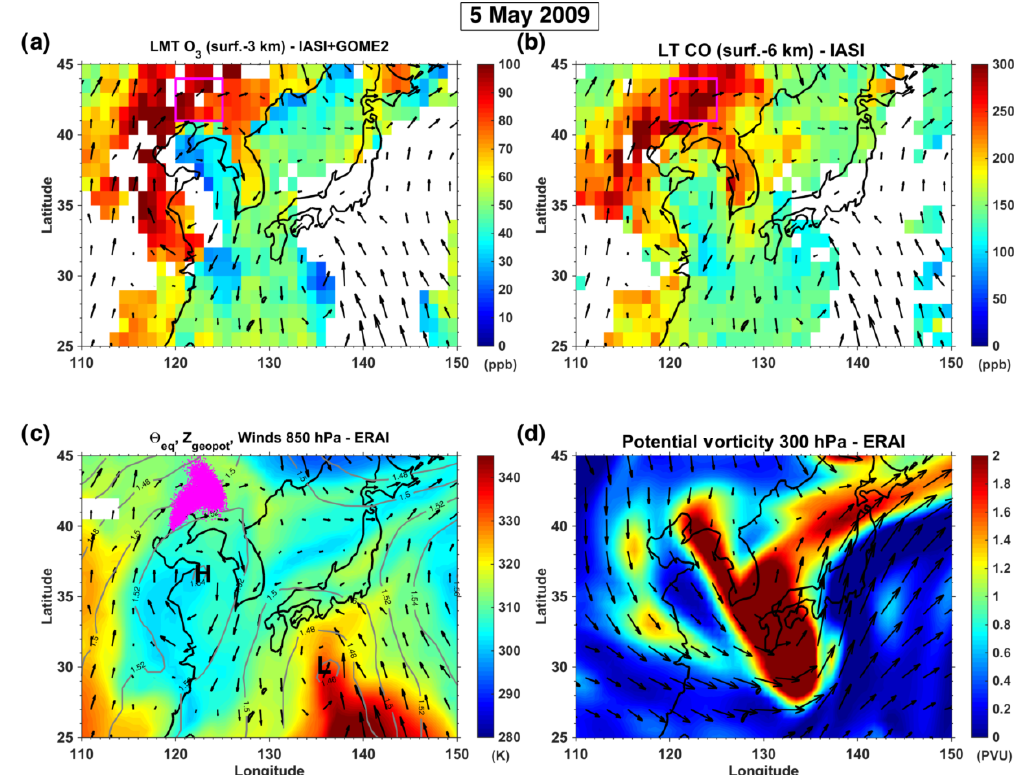
Figure 8. Same as Fig. 7 but for 5 May